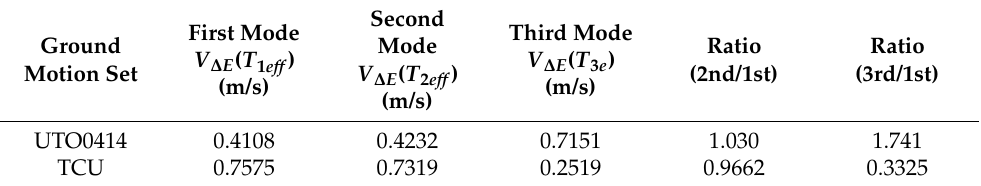
Table 6. Equivalent velocities of the maximum momentary input energy predicted from the bidirec- tional V ∆ E spectrum ( β =